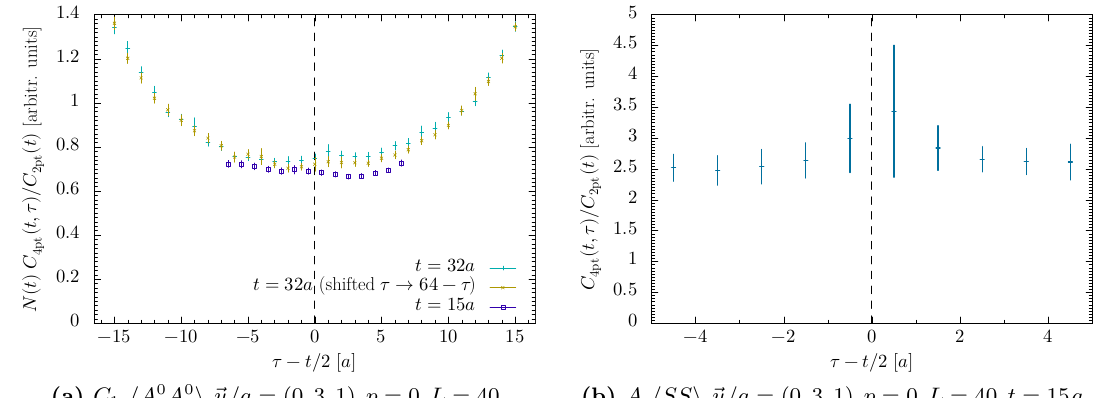
Figure 4. Dependence of the four-point function on the current insertion time (cid:28) at a (cid:12)xed distance ~y between the two currents. Shown are the contributions of the contraction C 1 to the correlator A 0 A 0 and of the contraction A to SS . Here and in all following plots, errors are purely statistical. h i h i The normalisation factor N ( t ) is speci(cid:12)ed in the text. p denotes the pion momentum and L the spatial lattice extent. Unless mentioned otherwise, all data shown in this paper are for light